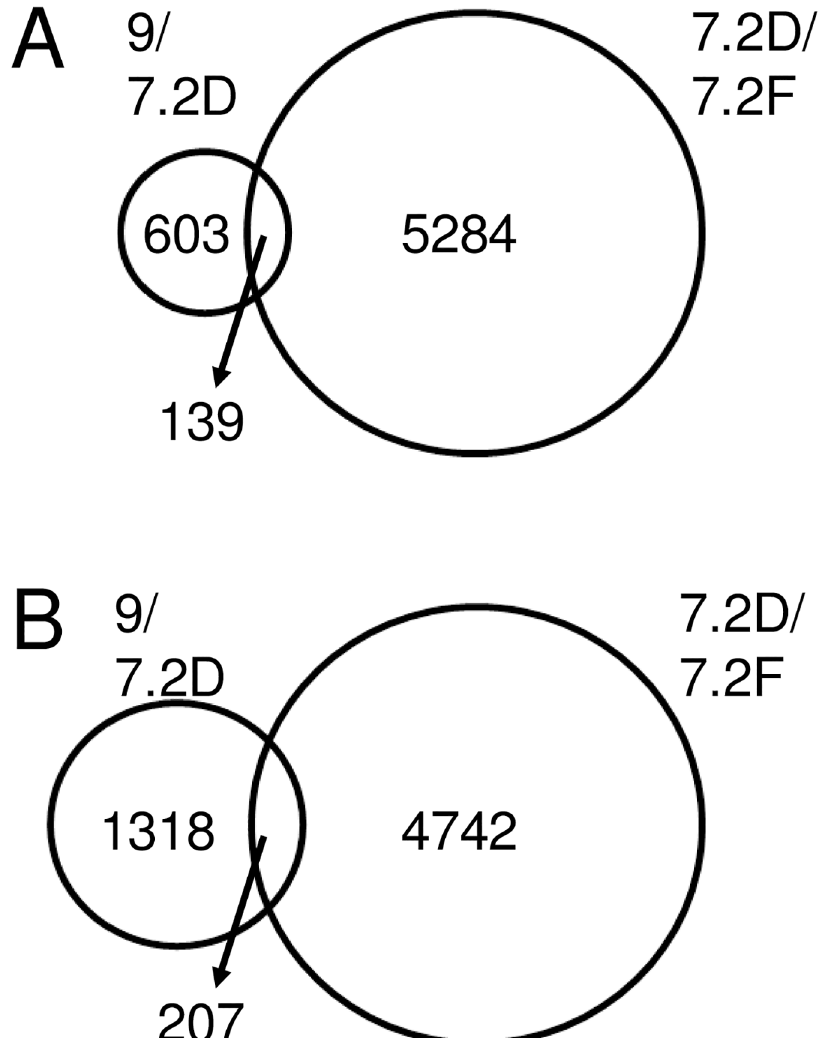
Fig 9. Venn diagrams identify transcripts correlating with longevity. Venn diagramscomparing transcripts that are differentially expressedin immature seeds that are rapidly dried at stage 7.2 (7.2D) comparedto dry, mature seeds (stage 9) and transcripts that are differentiallyexpressedbetweenfreshly harvestedseeds at stage 7.2 (7.2F) and rapidly dried seeds at stage 7.2 (7.2D). Genes were considered statistically different when the absoluteratio was at least two fold with a P(BH) < 0.01. (A). Number of genes with highertranscript levels in 9 vs 7.2D. (B). Number of genes with lower transcript levels in 9 comparedto 7.2